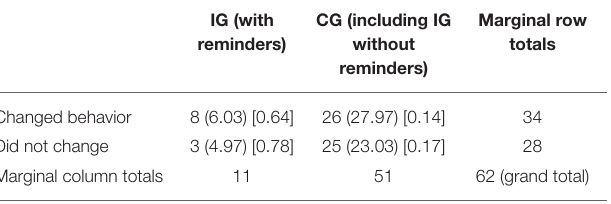
TABLE 8 | Test of the study hypothesis that genetic tests make DTCGT participants change their behavior in the short term (1-month follow-up) when using eHealth services with strategic methods: information chunking and creating personalized reminders and goals on their digital device.